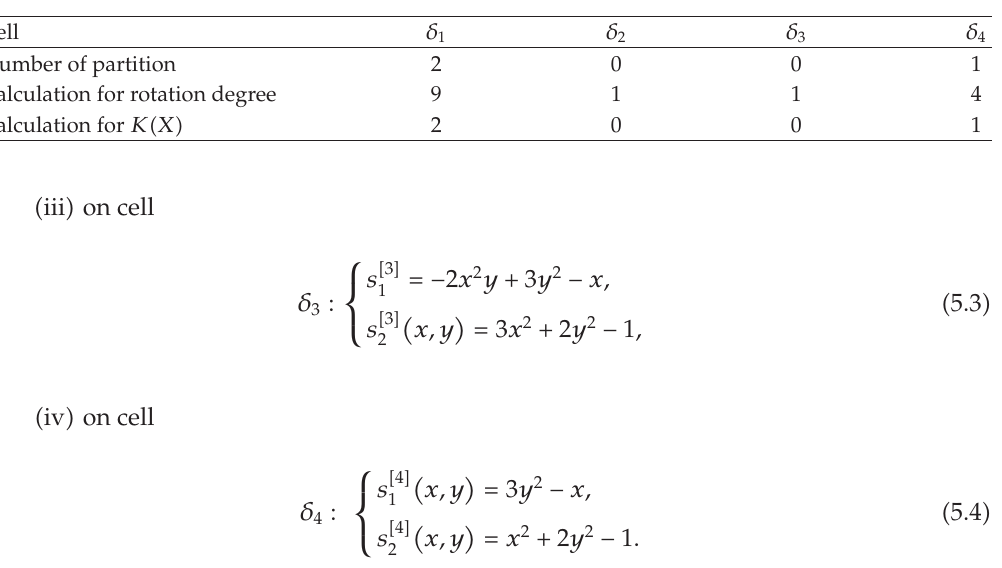
Figure 2: Two piecewise algebraic curves s 1 (cid:5) x,y (cid:6) (cid:4) 0 and s 2 (cid:5) x,y (cid:6) (cid:4) 0. Table 1: Computational complexity for isolating the real